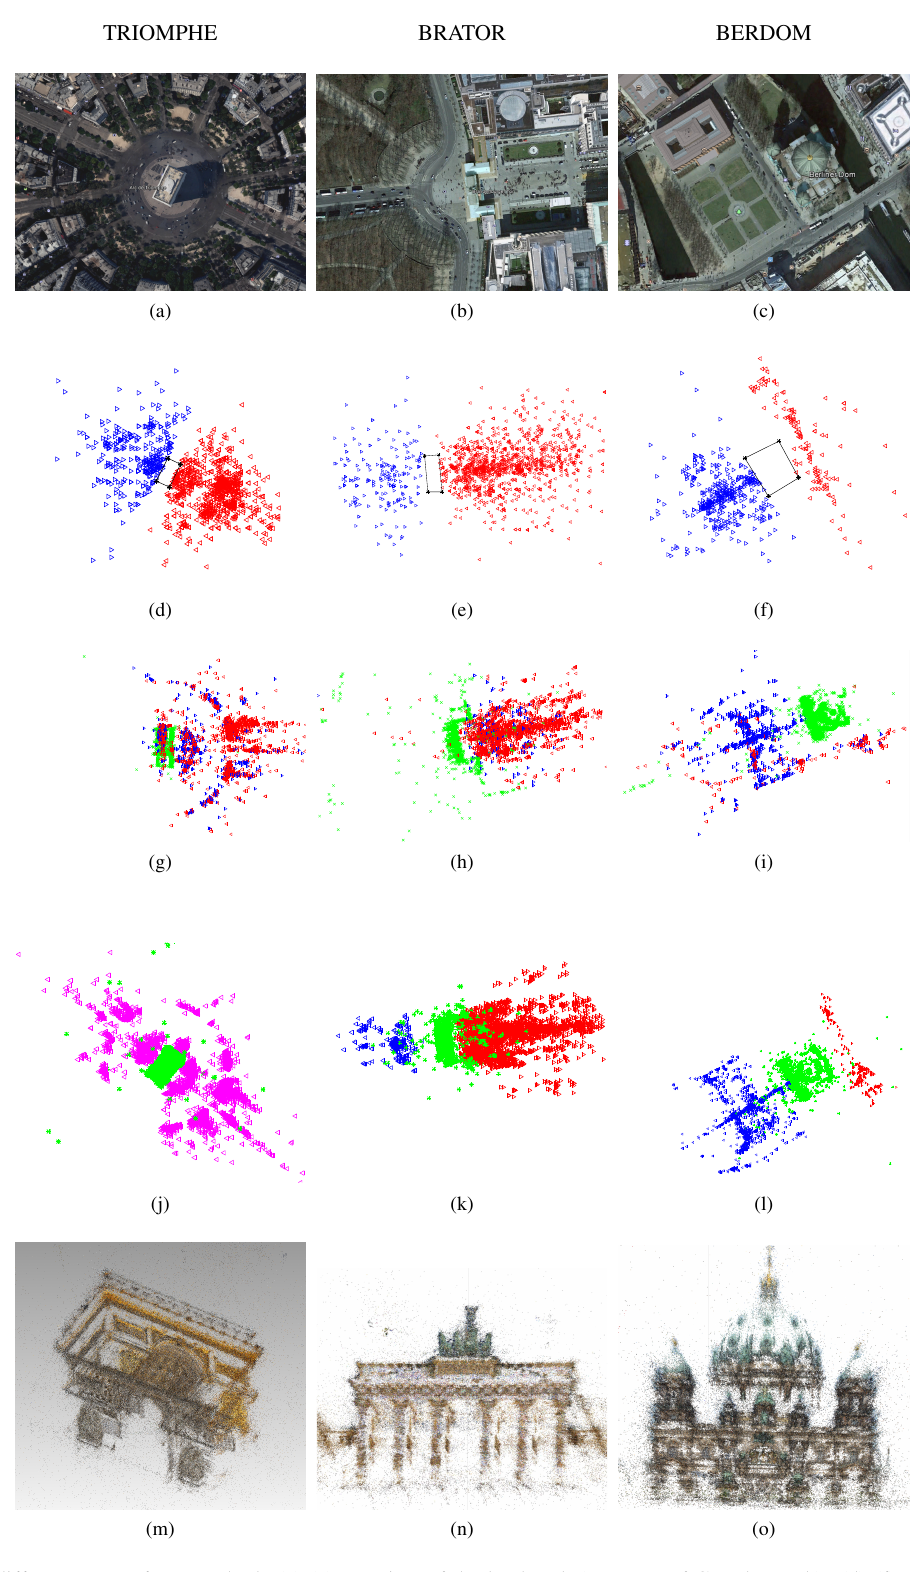
Figure 4. The different steps of our method. (a)-(c) top view of the landmark (courtesy of Google Earth). (d)-(f) cameras (red/blue triangles) with GNSS information. (g)-(i) reconstruction with Bundler when using no GNSS and standard VocMatch parameters. The cameras have the same color as in (d)-(f). (j)-(l) results using the proposed method (different colors for each cluster). (m)-(o) example views of the 3D point